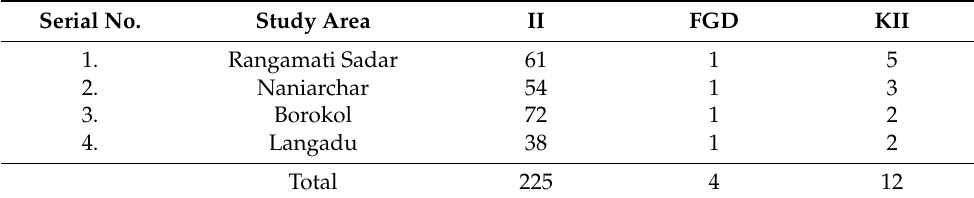
Table 1. Number of interviews in the study-surveyed areas. Serial